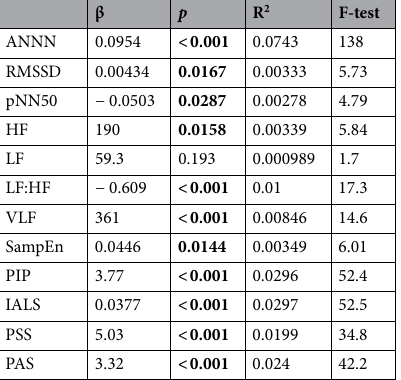
Table 3. Univariate linear regression mode of the relation between beta-blocker therapy and heart rate variability features in preserved ejection fraction (HFpEF). Significant values are in